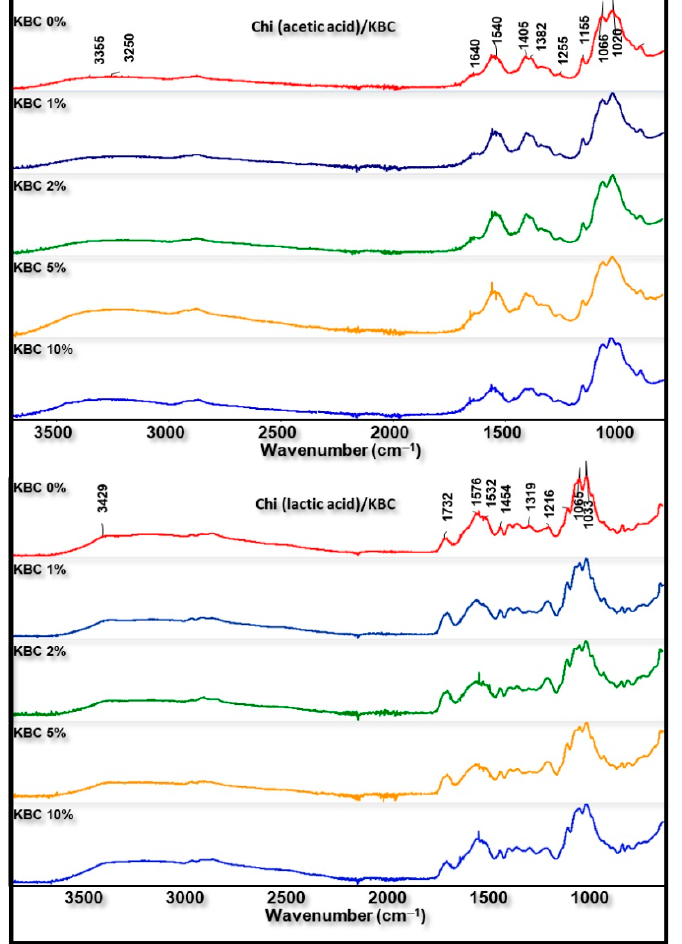
Figure 3. FTIR spectra of prepared films (Chi (acetic and lactic acid)/KBC) at various concentrations of KBC.